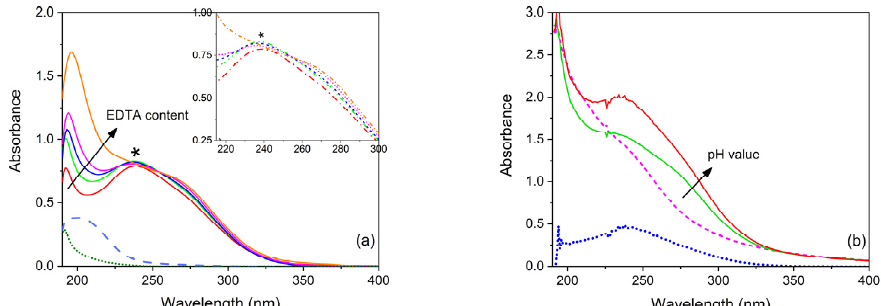
Figure 2. ( a ) UV-Vis absorbance spectra of free aqueous solutions containing CuSO 4 and ethylenedi- aminetetraacetic acid (EDTA) at increasing M:L molar ratios (1:1, 1:2, 1:3, 1:4 and 1:10); the spectra of solutions of EDTA (dotted curve) and CuSO 4 (dashed curve) are also reported for comparison. The asterisk * reports the position of the 239 nm band. ( b ) UV-Vis absorbance spectra of agar gels containing CuSO 4 and EDTA in a molar ratio of 1:1 at increasing pH (6.0 and 10.0), together with the spectrum resulting from their subtraction (dotted curve). The spectrum of agar gel containing only CuSO 4 is also reported for comparison (dashed curve). Gel samples are 1 mm thick and the optical path for solutions in the cuvette is 1